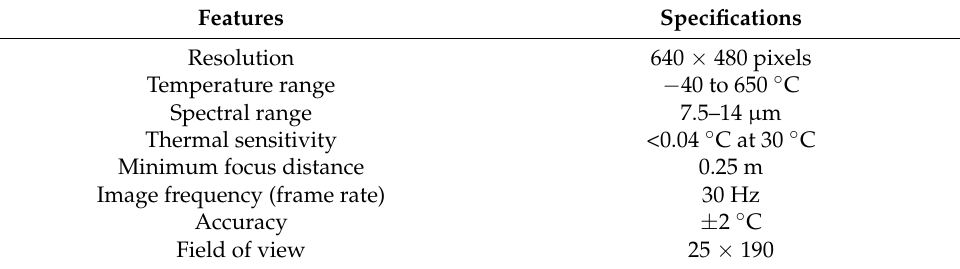
Table 2. The specifications of FLIR T-620 thermal